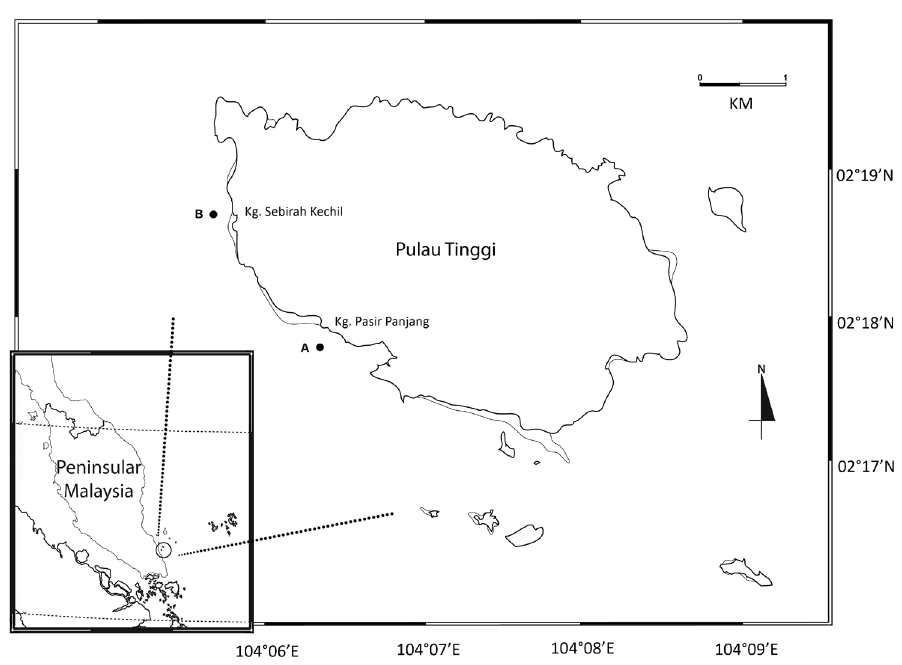
Figure 1. Map of the study area, A Kampung Pasir Panjang and B Kampung Sebirah Kechil, Pulau Tinggi, Sultan Iskandar Marine Park,